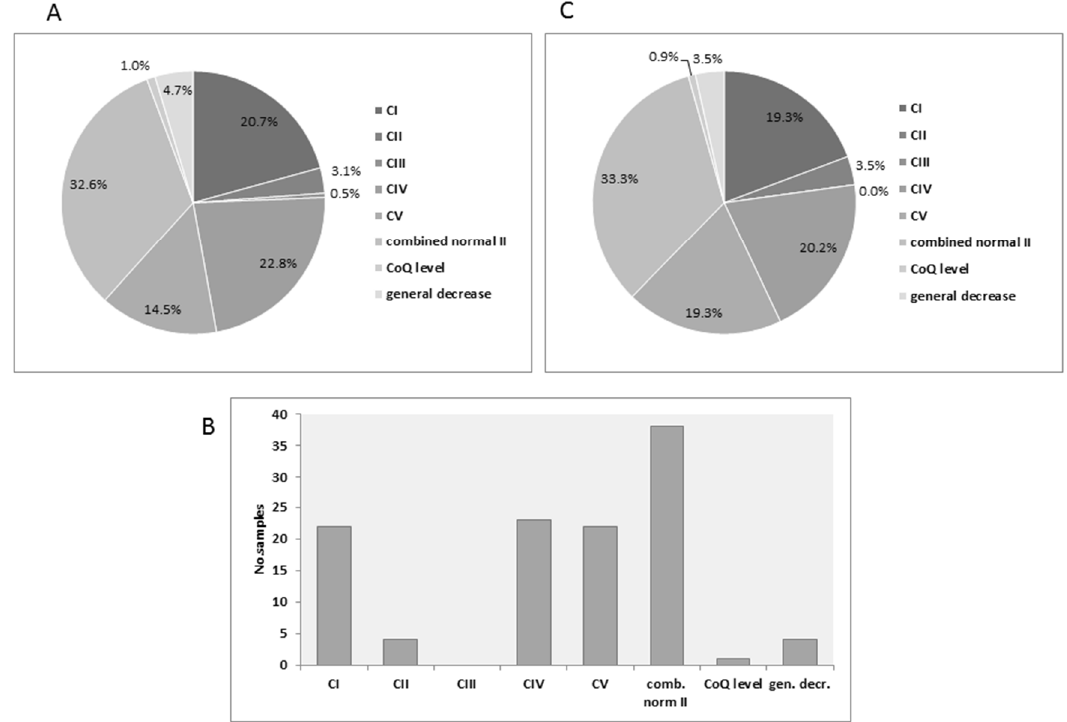
Figure 1. Distribution of MRC deficiencies: ( A ) The relative proportion of MRC defects according to groups. ( B ) The number of samples from each group with available metabolic test data. ( C ) The relative proportion of MRC defects with available metabolic test data.